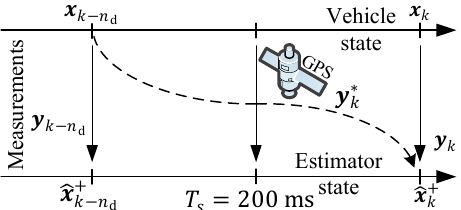
Figure 2. Delayed Global Positioning System (GPS) measurements incorporation in vehicle position estimation.